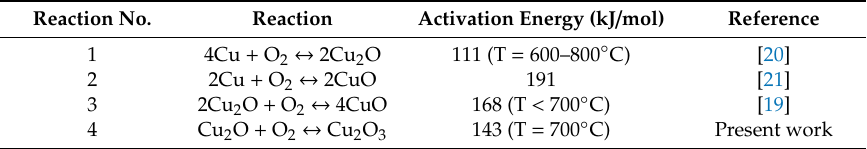
Figure 3. SEM micrographs of the surfaces of the Cu samples (magnified at 10,000×) subjected to oxygen plasma with varying irradiation times: ( a ) untreated; ( b ) 60 s; ( c ) 180 s; and ( d ) 300 s. Table 2. Model reaction set with the corresponding activation energy of the products. Reaction No.